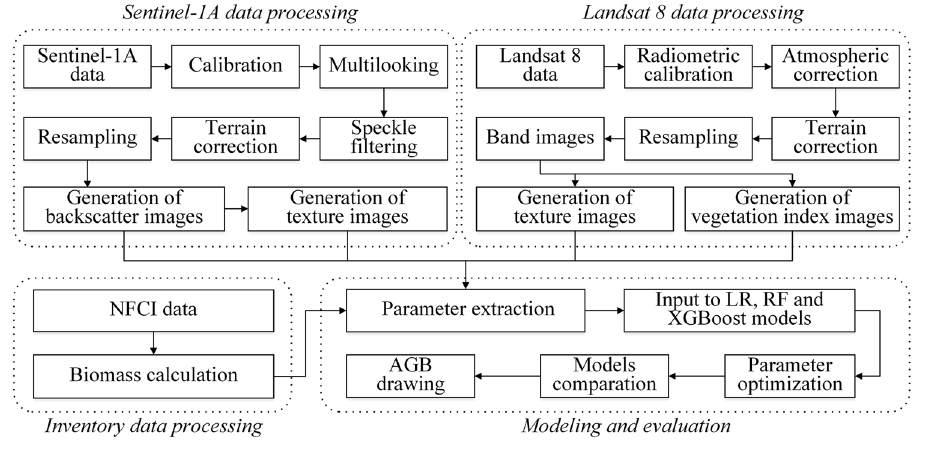
Figure 2. Workflow of the AGB estimation